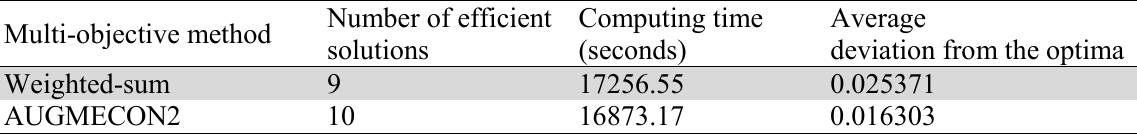
Results for the third scenario and ten grid points.